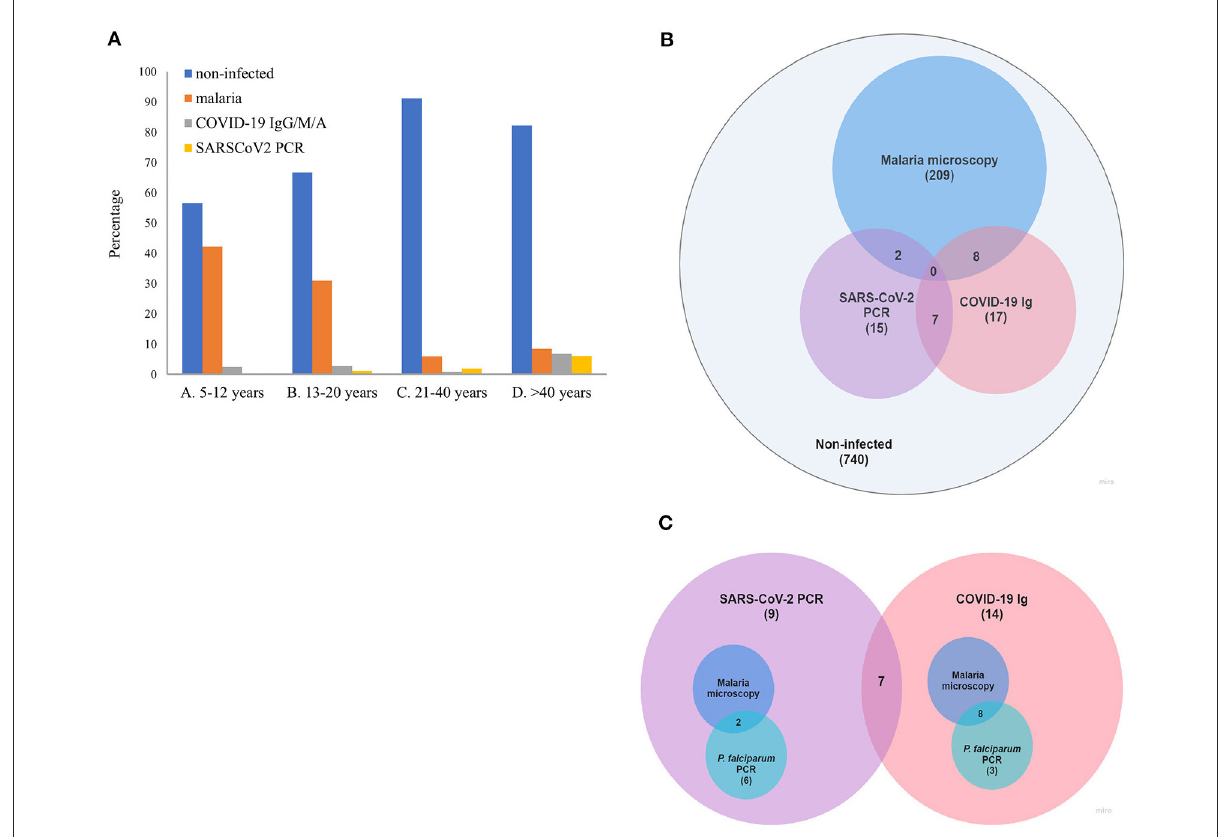
FIGURE1 (A) Prevalence of SARS-CoV-2 and malaria by age group. (B) Venn diagram representation of positive SARS-CoV-2 and malaria cases in the whole sampled population. (C) Venn diagram representation of SARS-CoV-2/malaria co-infection in the set of SARS-CoV-2 positive